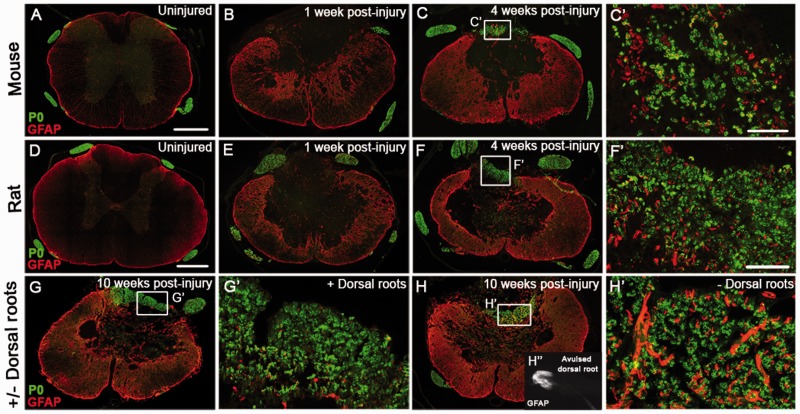
Schwann cell-mediated remyelination in mouse and rat spinal cords follows the
same time course and is unhindered by avulsion of multiple dorsal roots at and
adjacent to the injury site. (A–C)
Co-staining of astrocytes (GFAP, red) and Schwann cell-associated myelin (P0,
green), shows the time course of the appearance of Schwann cell myelin the injured
mouse spinal course. Peripheral myelin (P0) is not apparent in uninjured mouse
spinal cord (A) or at 1 week post-injury (B), but is
present in the dorsal columns by 4 weeks after injury (C).
C’ shows a high magnification of the boxed area in panel
C. (D–F) Co-staining of astrocytes
(GFAP, red) and Schwann cell-associated myelin (P0, green), shows the time course of
the appearance of Schwann cell myelin the injured rat spinal course. Peripheral
myelin (P0) is not apparent in uninjured rat spinal cord (D) or at 1
week post-injury (E), but is present by 4 weeks after injury
(F). F’ shows high magnification of the boxed area
in panel F. (G and H) At 10 weeks post-injury
Schwann cell-mediated remyelination is apparent after spinal contusion injury
irrespective of presence (G) or absence (H) of dorsal
roots, one of the main possible peripheral sources of the Schwann cells.
G’ and H’ show high magnifications of boxed
areas in panels G and H. (H’’)
Example of an avulsed dorsal root, which encompasses the entire rootlet including
the dorsal root entry zone that is visualized by staining of the astroglial marker
GFAP. Scale bars = 250 µm (A and D); 50
µm (C’ and F’). Images not using the
red/green colour scheme are available in the Supplementary material.